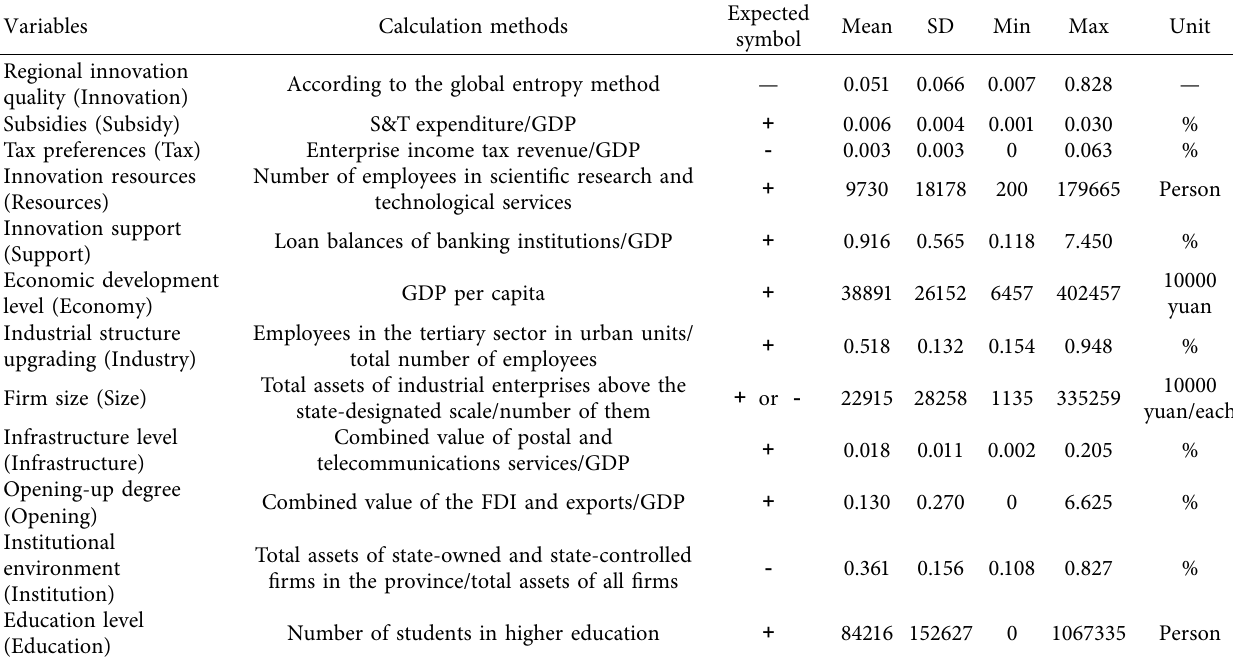
Table 2: Results of descriptive statistics ( N �